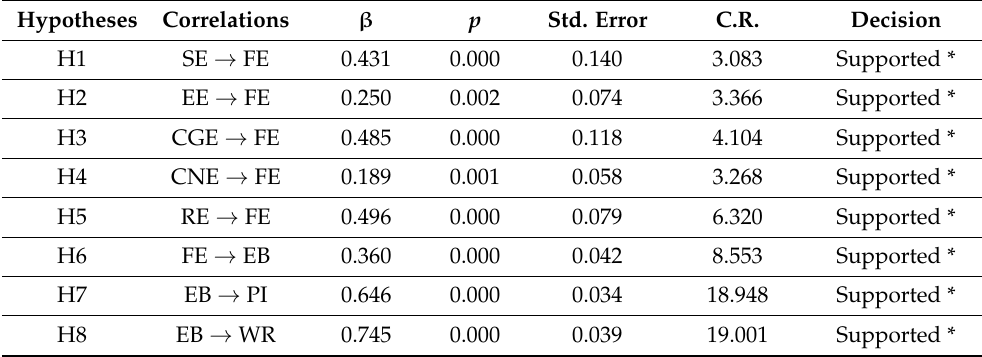
Table 4. The structural model